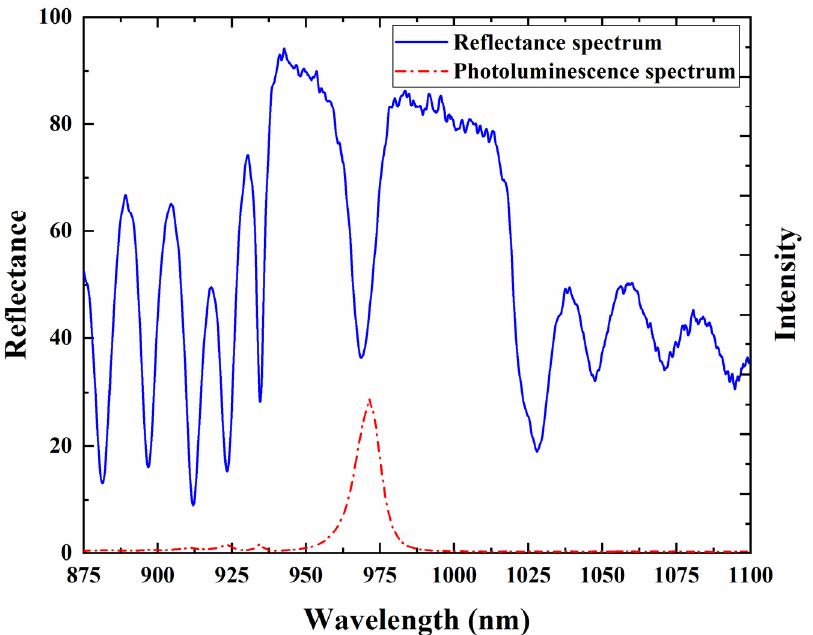
Figure 6. Gain chip reflection spectrum (solid line) and PL spectrum C (dashed red line) of the InGaAs chip obtained at 0°.